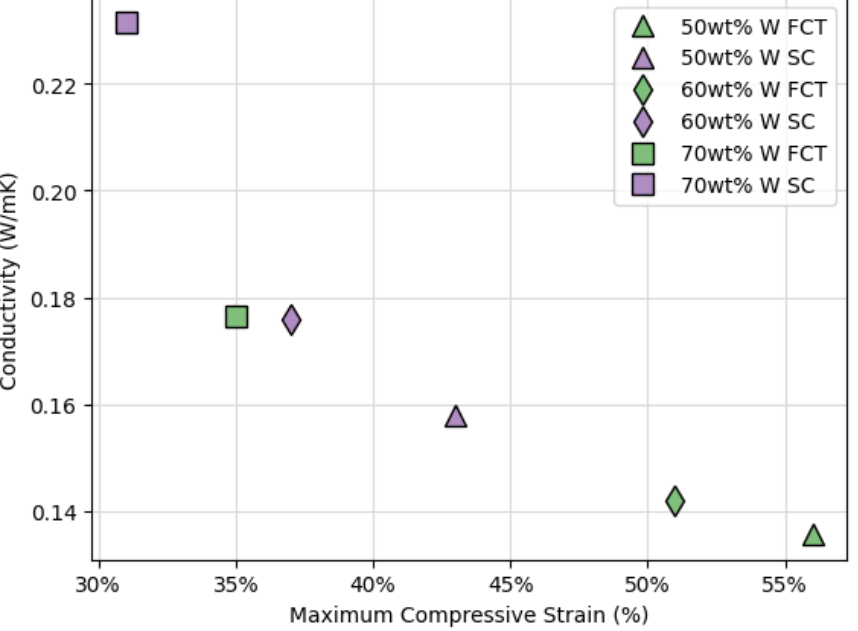
Figure 16. Schematic of thermal conductivity pathways in pads with: ( a ) SC lattice structure and ( b ) FCT lattice structure.